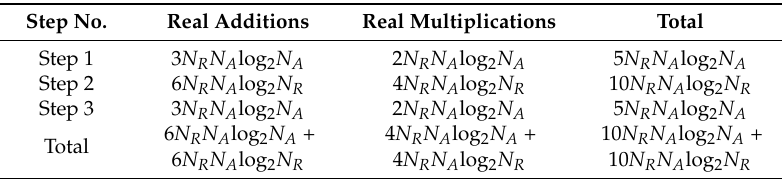
Table 1. Computational burden of FFT/IFFTs in different steps.